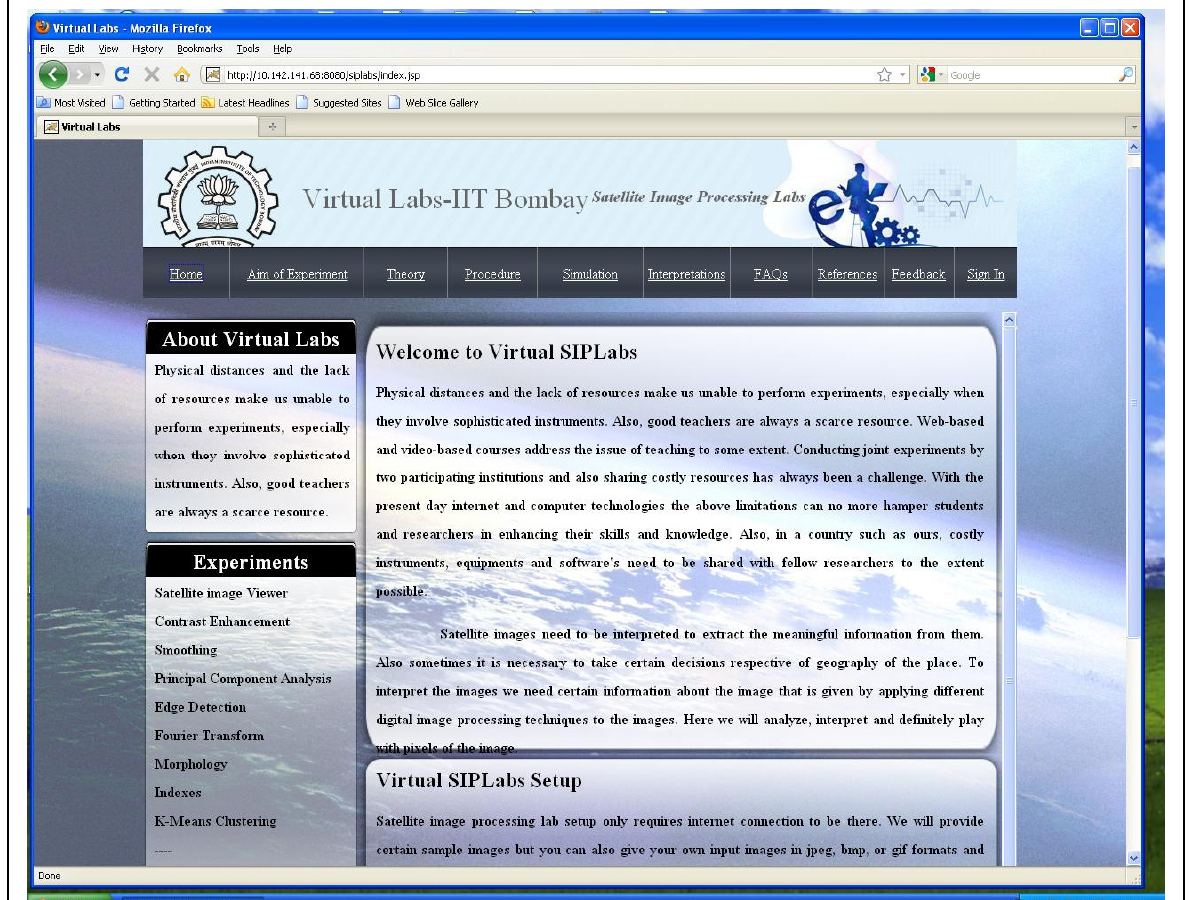
Figure 1. Front-end of the Virtual